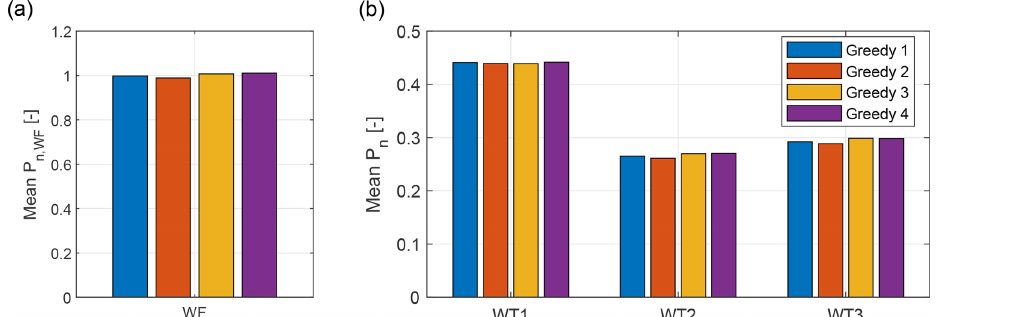
Figure 11. Repeatability of the experiments: averaged, normalized power for the wind farm (a) and the individual wind turbines (b) for four 90min repetitions with the greedy control strategy.